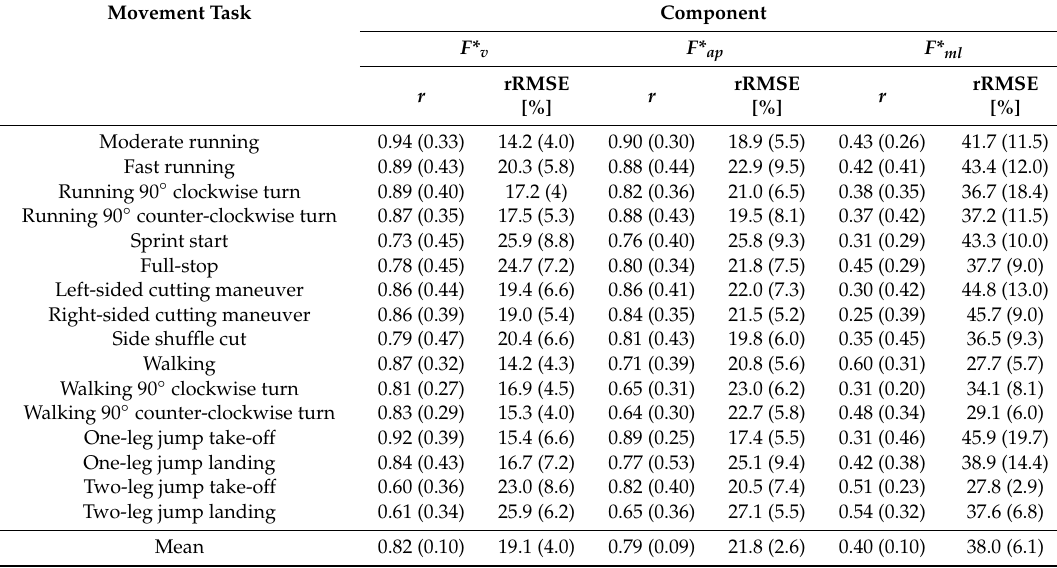
Table 1. Accuracy ( r : Pearson’s correlation coe ffi cient; rRMSE: relative root-mean-squared error) of the predicted continuous knee joint force outcomes (vertical ( F* v ), anterior–posterior ( F* ap ), and medial–lateral ( F* ml )). Values are presented as mean (and standard